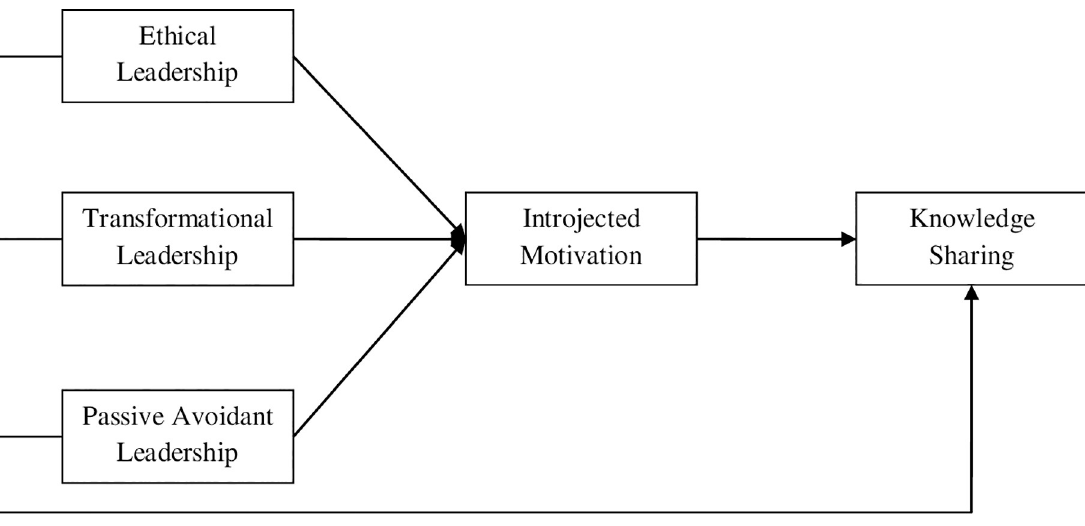
Fig 1. Proposed theoretical